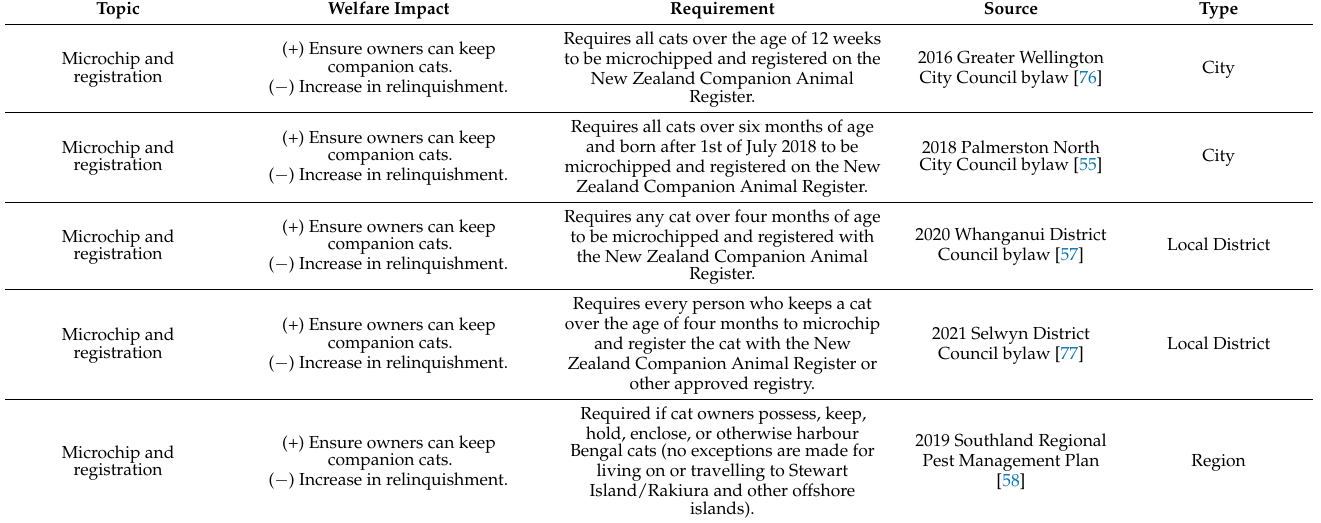
Table 3. Laws and regulations for